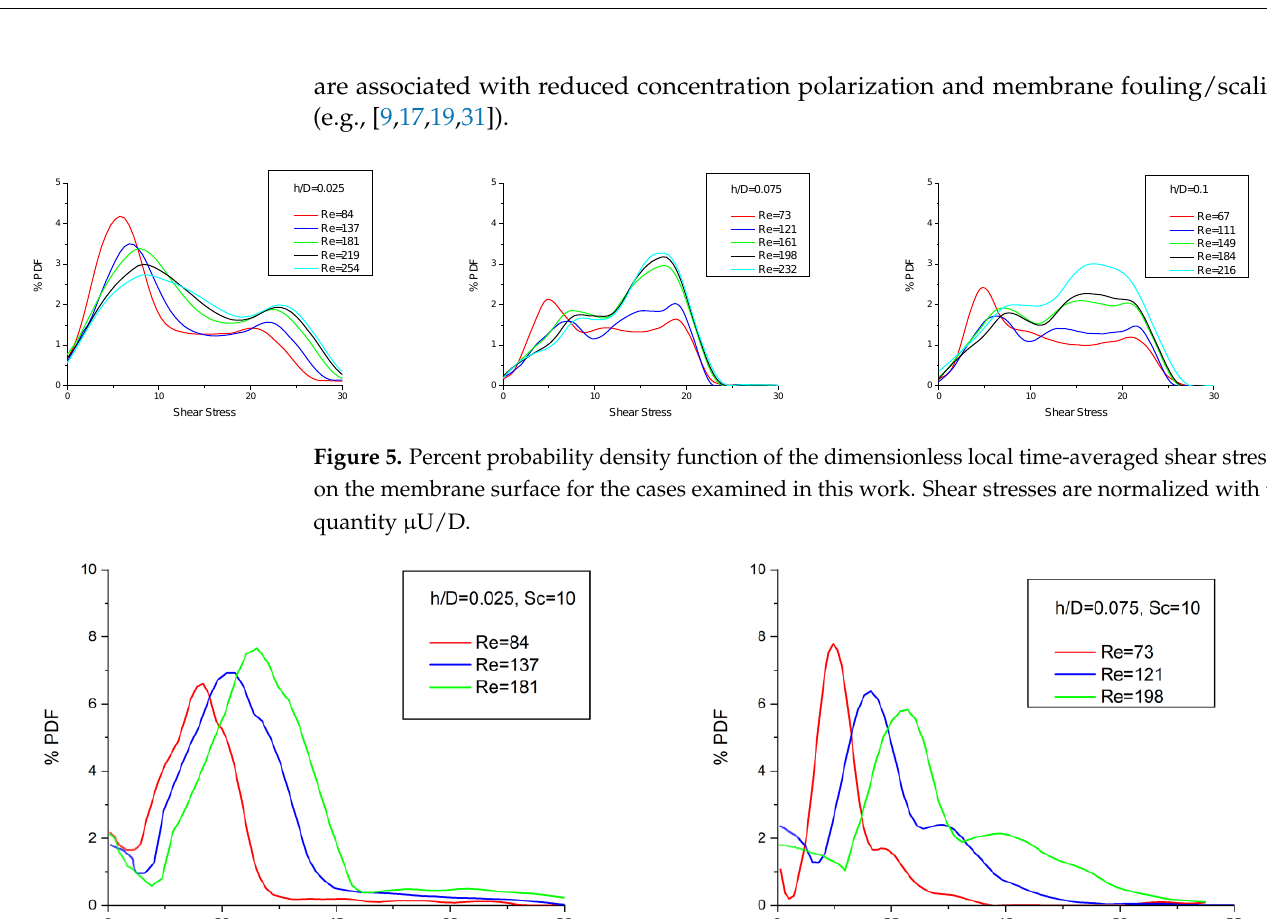
Figure 6. Probability density function of the local time-averaged Sh number at the membrane sur- face.